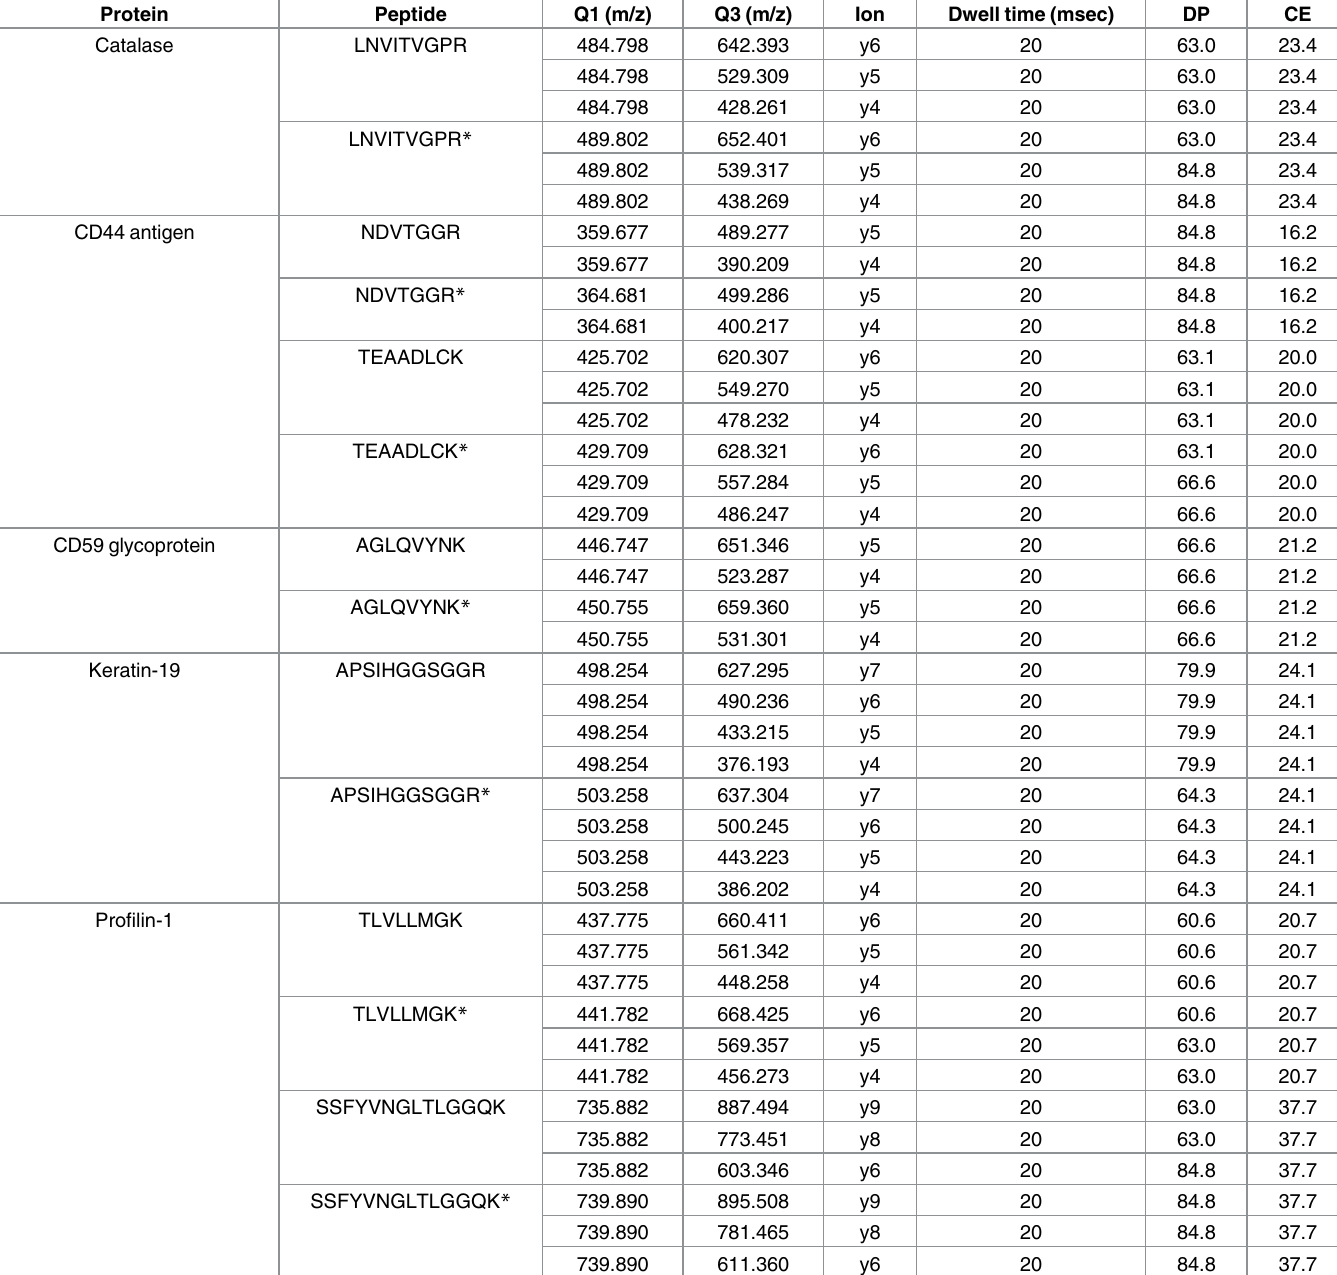
Table 3. Optimized SRM parameters used for the massspectrometric examination of salivaryproteins. The Q1 and Q3 m/z values, the type of “y” ion used, the dwell time, declustering potential(DP) and collisionenergy (CE) is indicatedin case of each studied peptide. Protein